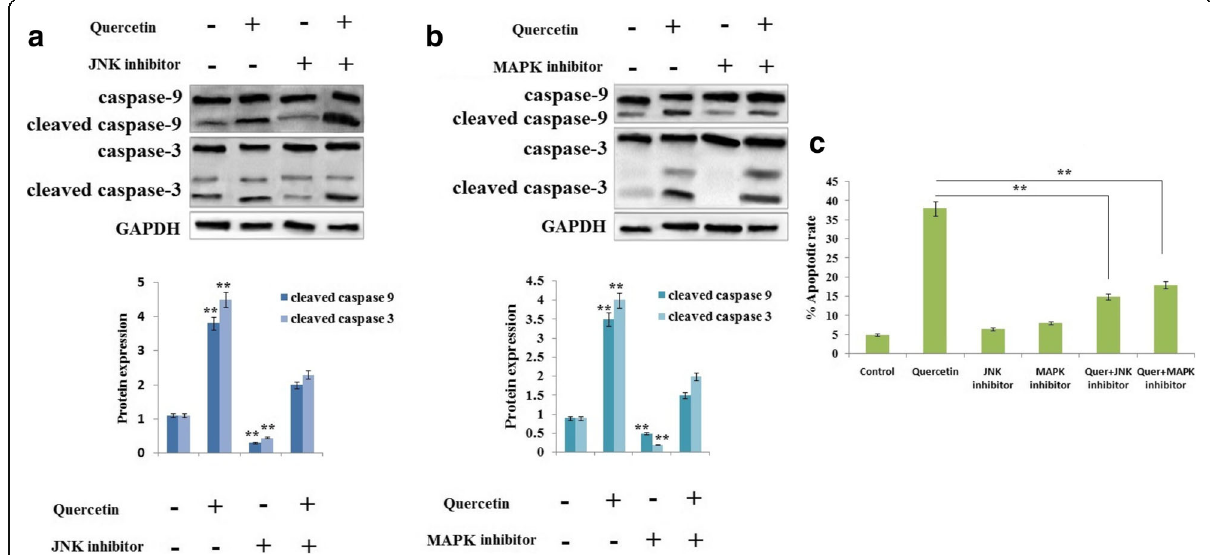
Fig. 7 Effect of Quercetin induced apoptosis in RB Y79 cells mediated by JNK and p38 MAPK. a and b The RB Y79 cells were exposed in the presence or absence of JNK inhibitor or MAPK inhibitor for 1 h followed by treatment with 100 μ M Quercetin for time period 24 h. Western blot analysis was done for levels of caspase-9 and -3, GAPDH was loading control. ** P < 0.01 against control (n = 3). c Total apoptotic population was analyzed using flow cytometry with staining of propidium iodide (PI) and Annexin V-fluorescein isothiocyanate (FITC). The data represented as means ± SD (n = 3), ** P <